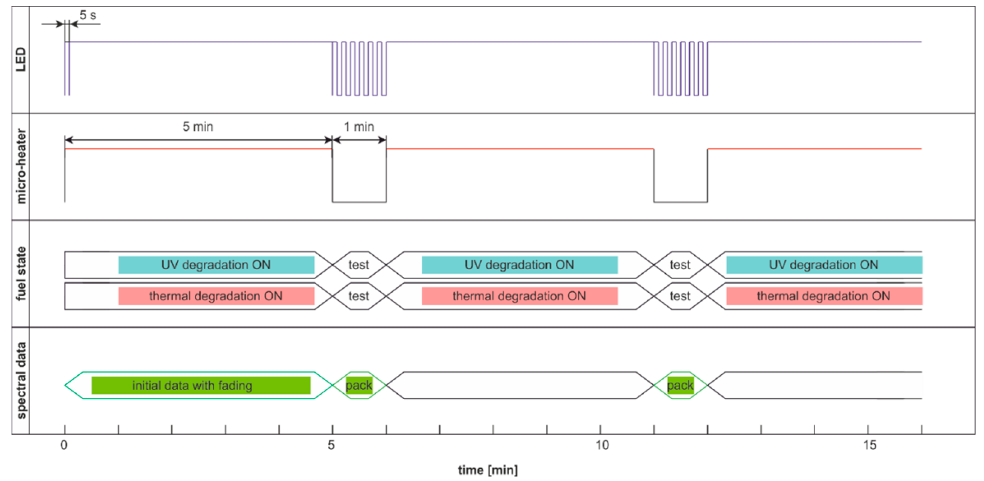
Figure 26. The hybrid cycle of degradation and examination uses thermal and UV radiations for degradation and modulated UV for analysis named DHE:UVonTon. Obtained time series are of the expected course, as presented in Figure 27. Initial values with active thermal factor increase rapidly, as in the DCE:UVonTon cycle. The following pack of data looks very similar to DME:UVonTon